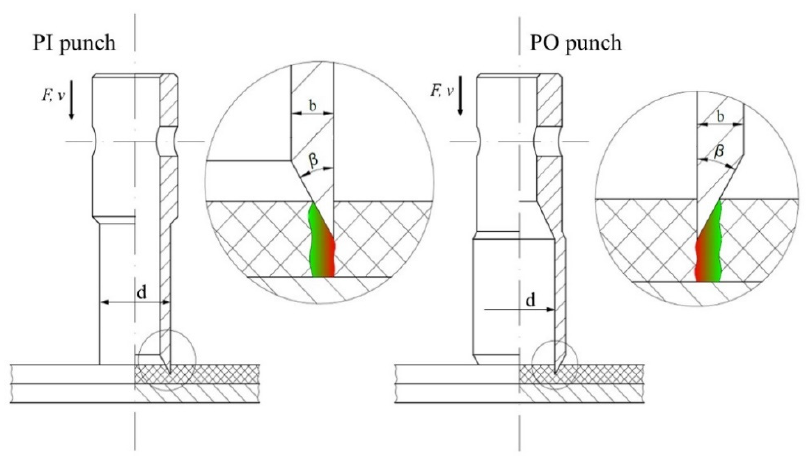
Figure 2. Schematic of the belt perforation process with single cutting edge.